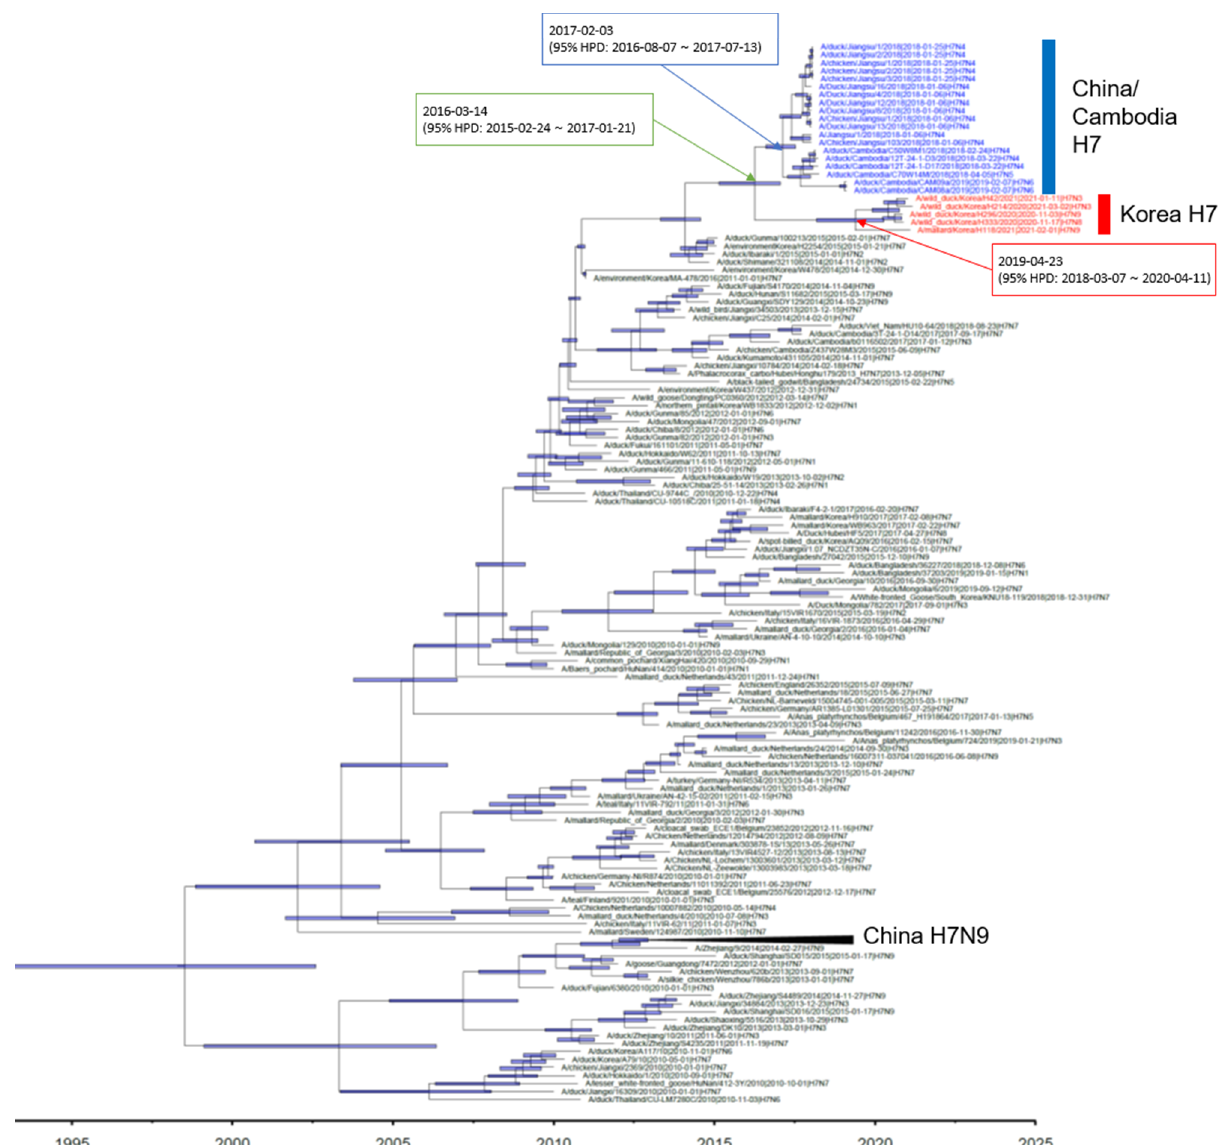
Figure 1. Maximum clade credibility phylogeny of the HA gene sequences of H7Nx avian influenza viruses in Eurasia. We estimated the maximum clade credibility tree using a time-measured Bayesian phylogenetic model implemented in BEAST v1.10.4. The Hasegawa–Kishino–Yano nucleotide substitution model, with a discrete gamma distribution with four categories, was applied. Branch lengths represent time. Horizontal bars indicate 95% Bayesian credible intervals for estimates of common ancestry. The H7Nx viruses isolated in China and Cambodia are colored with blue. The H7Nx viruses isolated in this study are colored with red. The estimated time of the most recent common ancestry with 95% highest posterior density (HPD) is displayed on the node of cluster.